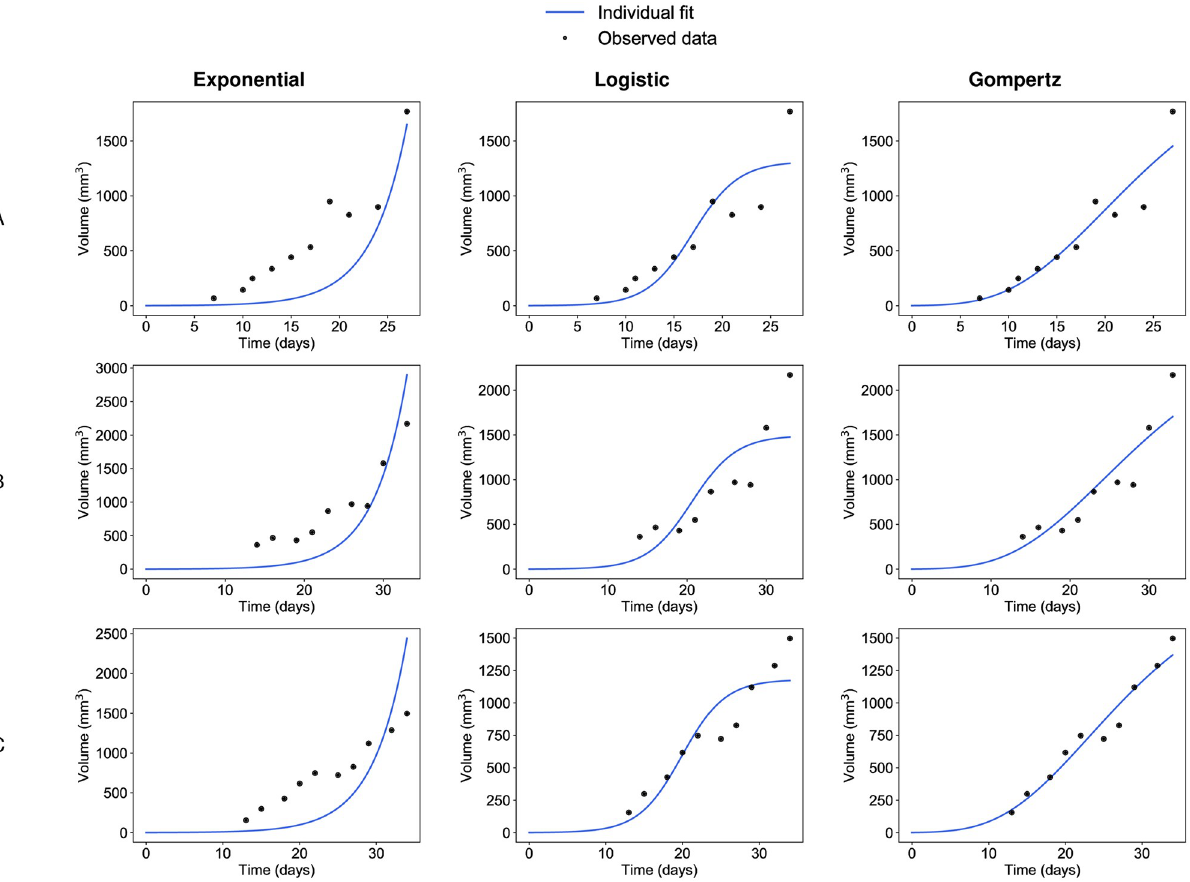
Fig 2. Individual fits from population analysis. Three representative examples of individual fits (animal (A), animal (B) and animal (C)) computed with the population approach relative to the exponential (left), the logistic (center) and the Gompertz (right) models.